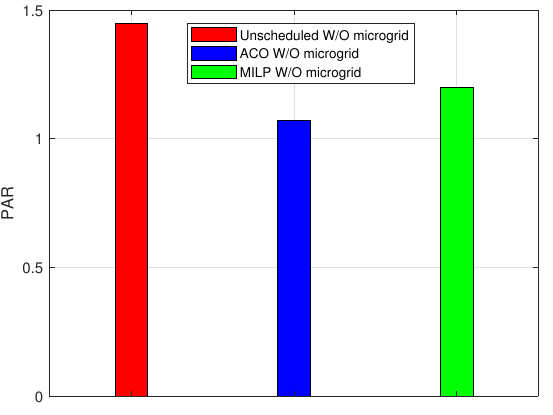
Figure 9. PAR minimization evaluation W/O considering microgrid.